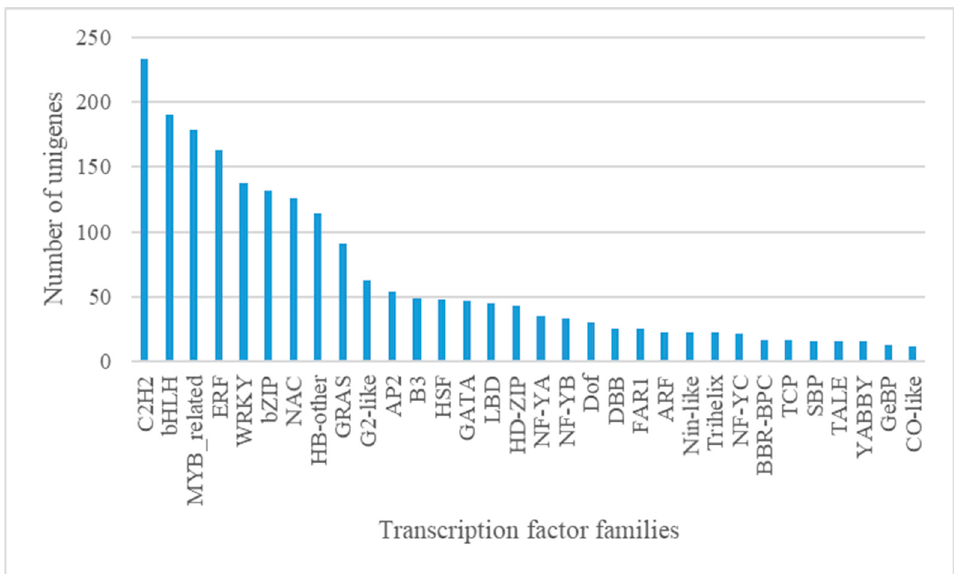
Figure 6. Unigenes of C. caudatus of transcription factors (TFs) in anthocyanin regulation. Graphs indicate the number of unigenes identified for the corresponding gene.